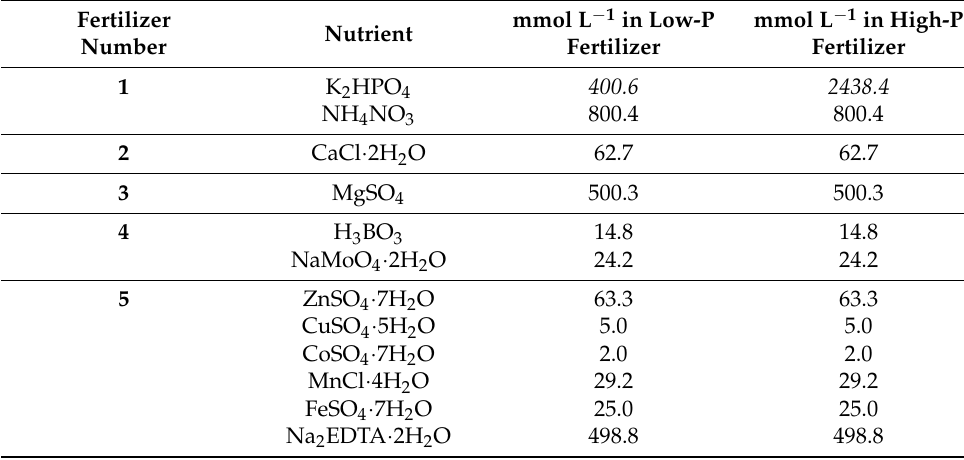
Table A1. Composition of fertilizer solutions 1–5 in the applied concentration.